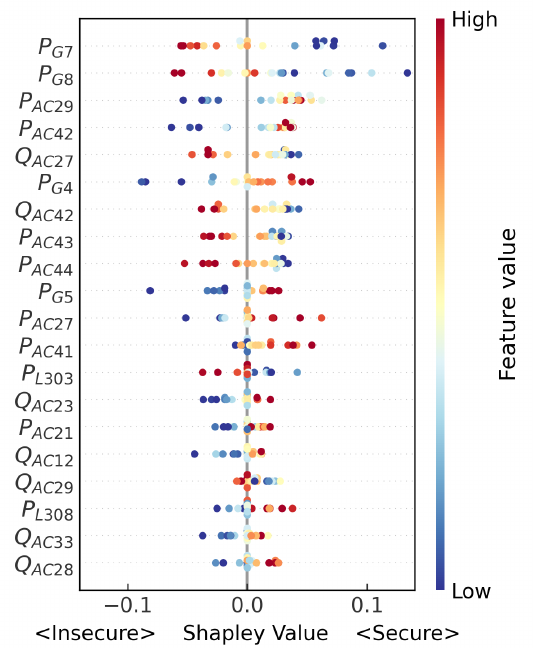
Figure 6. Global interpretation for 20